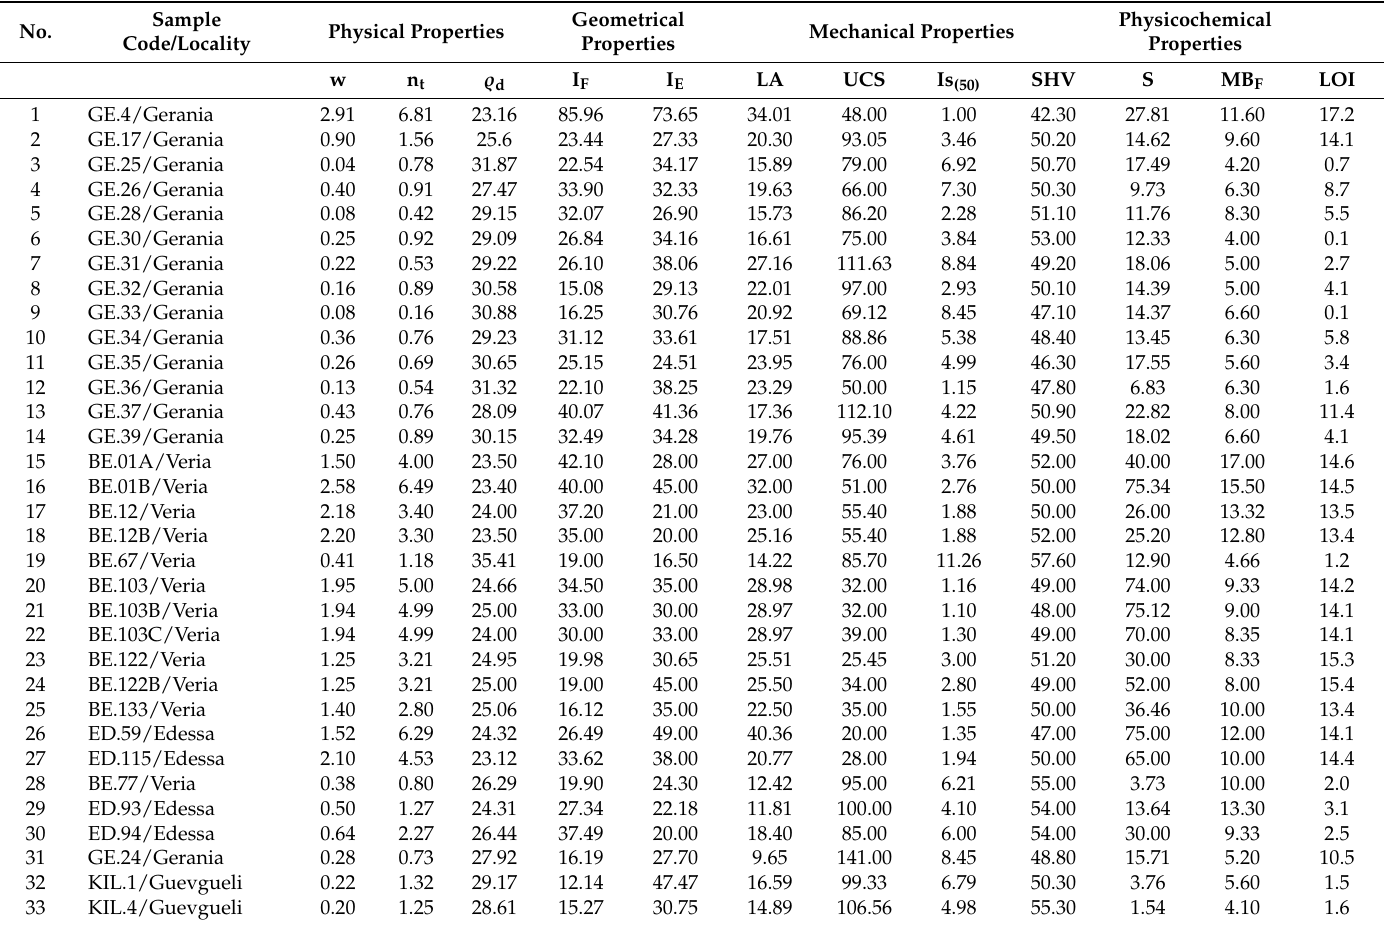
Table 2. Results of the engineering properties of the studied